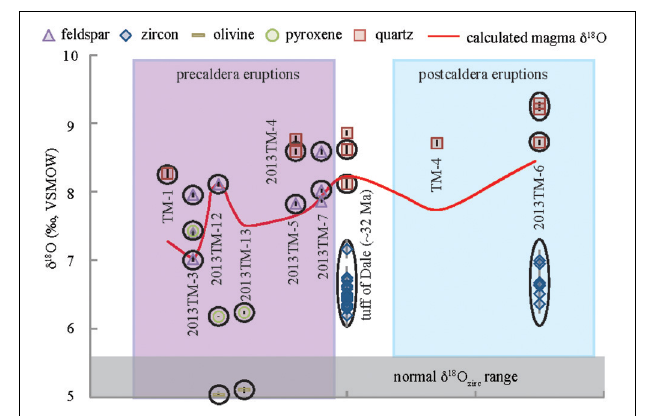
FIGURE 4 | δ 18 O vs. age for zircon, feldspar, quartz, olivine, and pyroxene for rocks associated with the Tower Mountain caldera. The age for the tuff of Dale is based on personal communication by Martin Streck. See Figure 3 for other symbols and explanations.